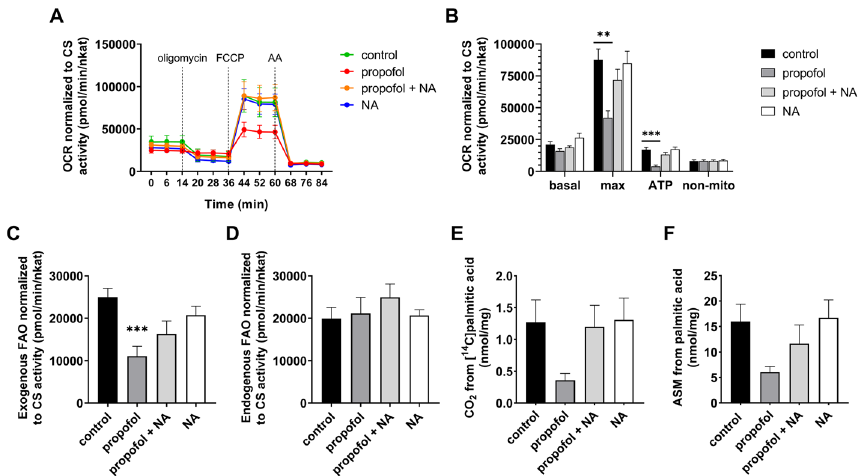
Fig. 1 Extracellular flux analysis and substrate oxidation assays. A Real-time measurement of OCR at baseline and after sequential injection of oligomycin, FCCP and antimycin A. Each data-point represents the mean of 7 subjects measured in tri- or tetraplicates. Values are normalized to mitochondrial content (CS activity). B Global mitochondrial parameters. Basal respiration, maximal respiratory capacity, ATP production and non-mitochondrial respiration determined from OCRs shown in part A. C Exogenous oxidation of fatty acids after palmitate addition to the medium during measurement. D Endogenous oxidation of fatty acids in palmitate-free medium. E CO 2 production from [ 14 C]palmitic acid (complete oxidation). F Oxidation of [ 14 C] palmitic acid to ASM (incomplete oxidation). Error bars in each graph indicate standard error of the mean. ** p < 0.01, *** p < 0.001 vs. control group. AA antimycin A, FCCP carbonyl cyanide-4- (trifluoromethoxy) phenylhydrazone, FAO fatty acid oxidation, NA noradrenaline, OCR oxygen consumption